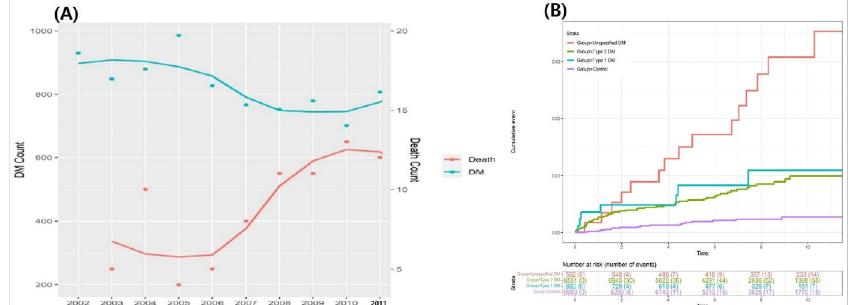
Figure 2. The number of diagnosed patients and deaths with diabetes mellitus ( A ). Cumula- tive hazard plot for death between the DM type and the control group ( B ). Abbreviations: DM, diabetes mellitus.